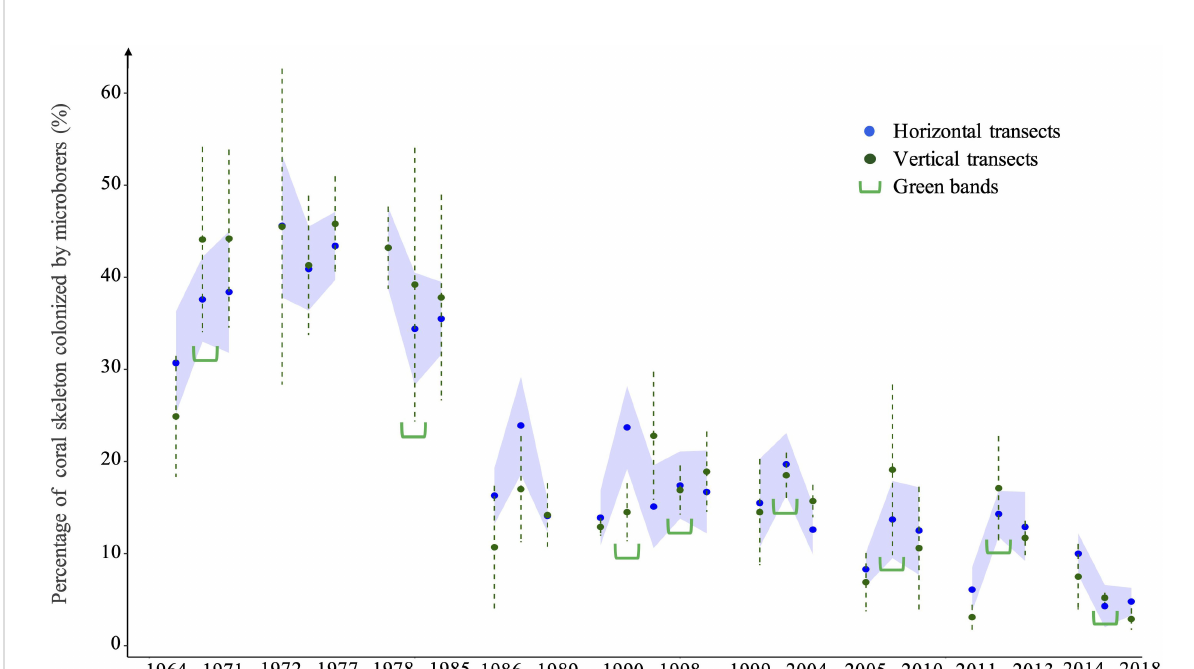
FIGURE 8 Variability of the percentage of coral skeleton colonized by microborer traces (microborings) obtained at the intersections between the studied vertical and horizontal transects along the coral core. Means obtained on horizontal transects are shown by blue dots, with their con fi dence interval (95%; indicated by the blue area). Means obtained on vertical transects are shown by green dots, together with their SE (dotted green line). Green parentheses indicate the presence of the studied visible green bands within the coral